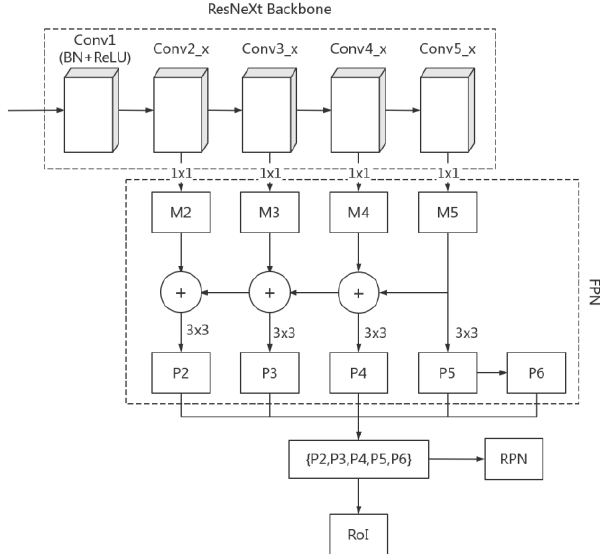
Figure 7. Schematic representation of the ResNeXt + FPN structure.